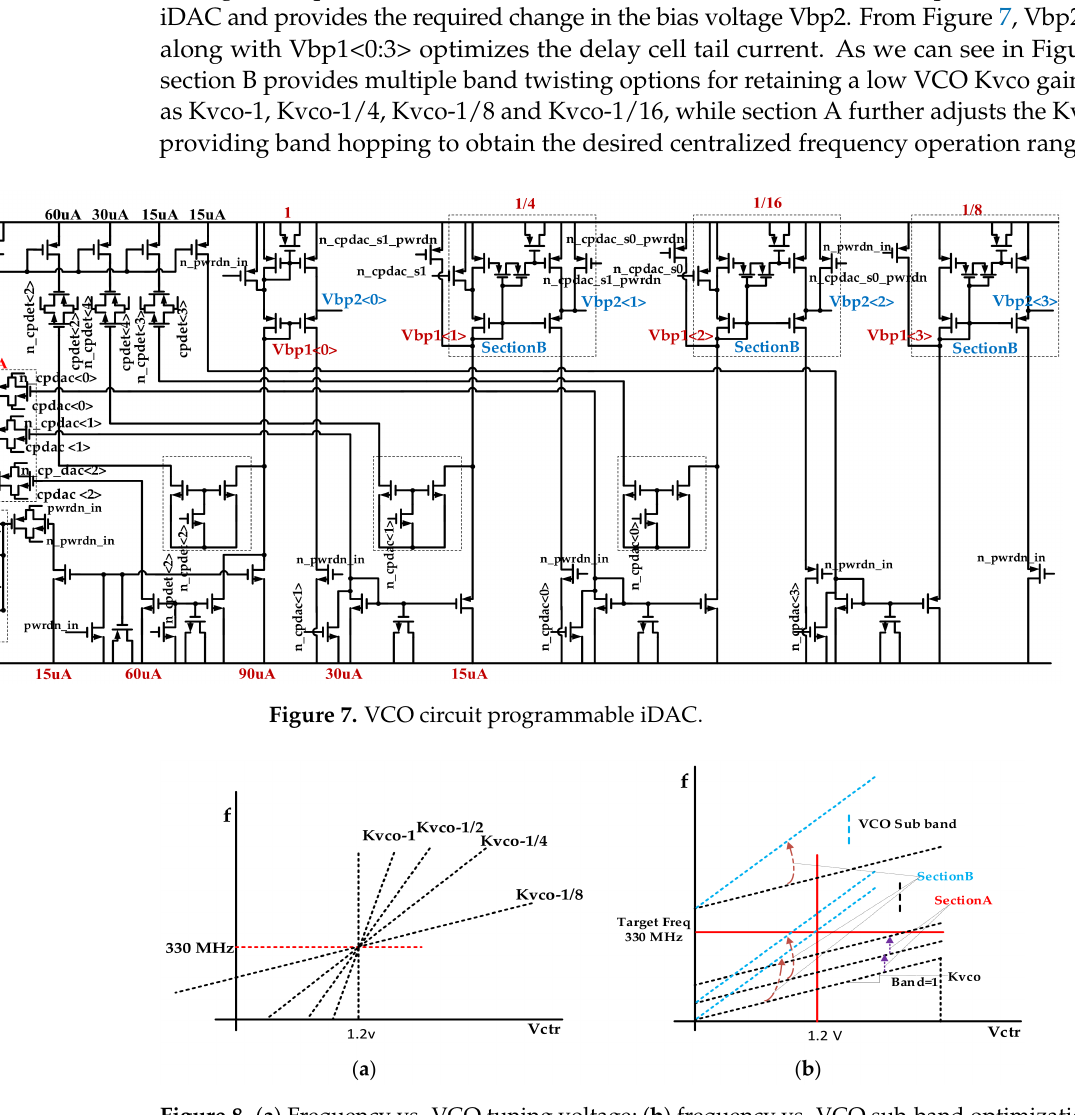
Figure 8. ( a ) Frequency vs. VCO tuning voltage; ( b ) frequency vs. VCO sub-band